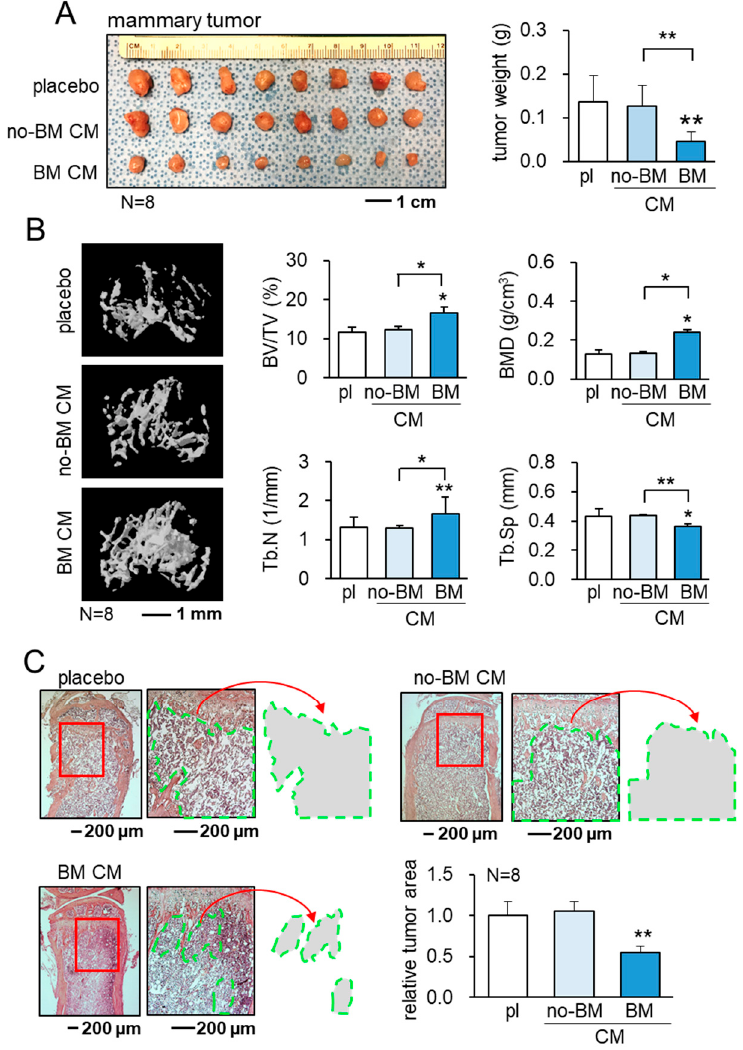
Figure 4. Suppression of the growth of mammary tumors and tumor-driven bone loss by BM CM. Tumor growth in C57BL/6 mice was evaluated 3 weeks after tumor inoculation. CN = control, no-BM CM = RAW-derived conditioned medium treated without BML284, and BM CM = BML284-treated RAW-derived conditioned medium. * p < 0.05 and ** p < 0.01. ( A ) Reduction in the size and weight of mammary tumors by BM CM. ( B ) Reduction in trabecular bone loss in the tumor-invaded proximal tibia by BM CM. BV/TV = bone volume ratio, BMD = bone mineral density, Tb.N = trabecular number, and Tb.Sp = trabecular separation. ( C ) Reduction in the tumor-invaded area in the proximal tibia by BM